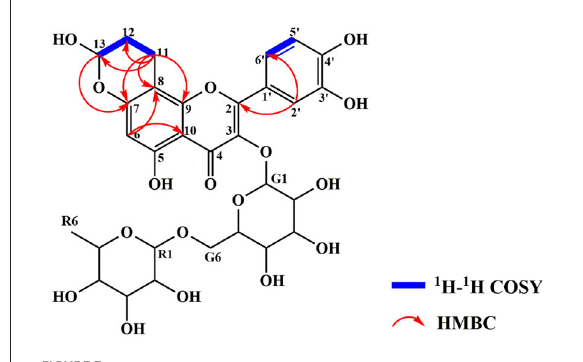
FIGURE3 The chemical structure and key 1 H- 1 H COSY and HMBC correlations of RAC.